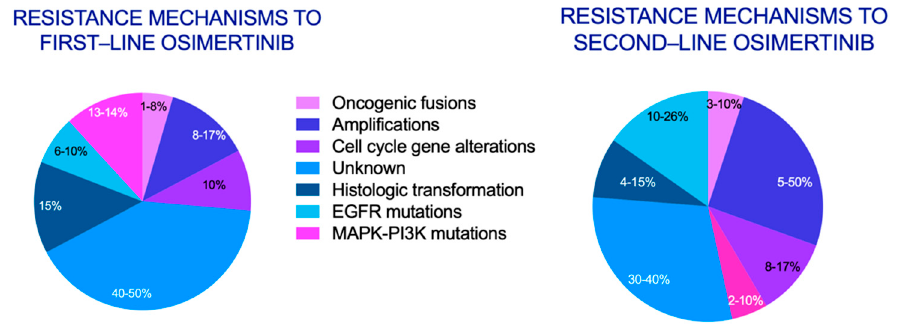
Figure 1. Resistance mechanisms to first- and second-line osimertinib. Adapted and reprinted from Leonetti et al. [16], Copyright © 2019, under exclusive license to Cancer Research UK. Cell cycle gene alterations (CCND1amp, CCND2amp, CCNE1amp, CDK6amp, CDKN2A E2fs), MAPK-PI3K mutations ( BRAF V600E , PIK3CA , KRAS ), oncogenic fusions ( FGFR , NTRK , RET , ALK , BRAF ), amplifications ( MET , HER2 , PIK3CA ), EGFR mutations (C797X, L792X, G796X, exon20 insertions, etc.), histologic transformations (SCLC and SCC). Table 1. Mechanism of resistance to osimertinib and proposed therapeutic options.